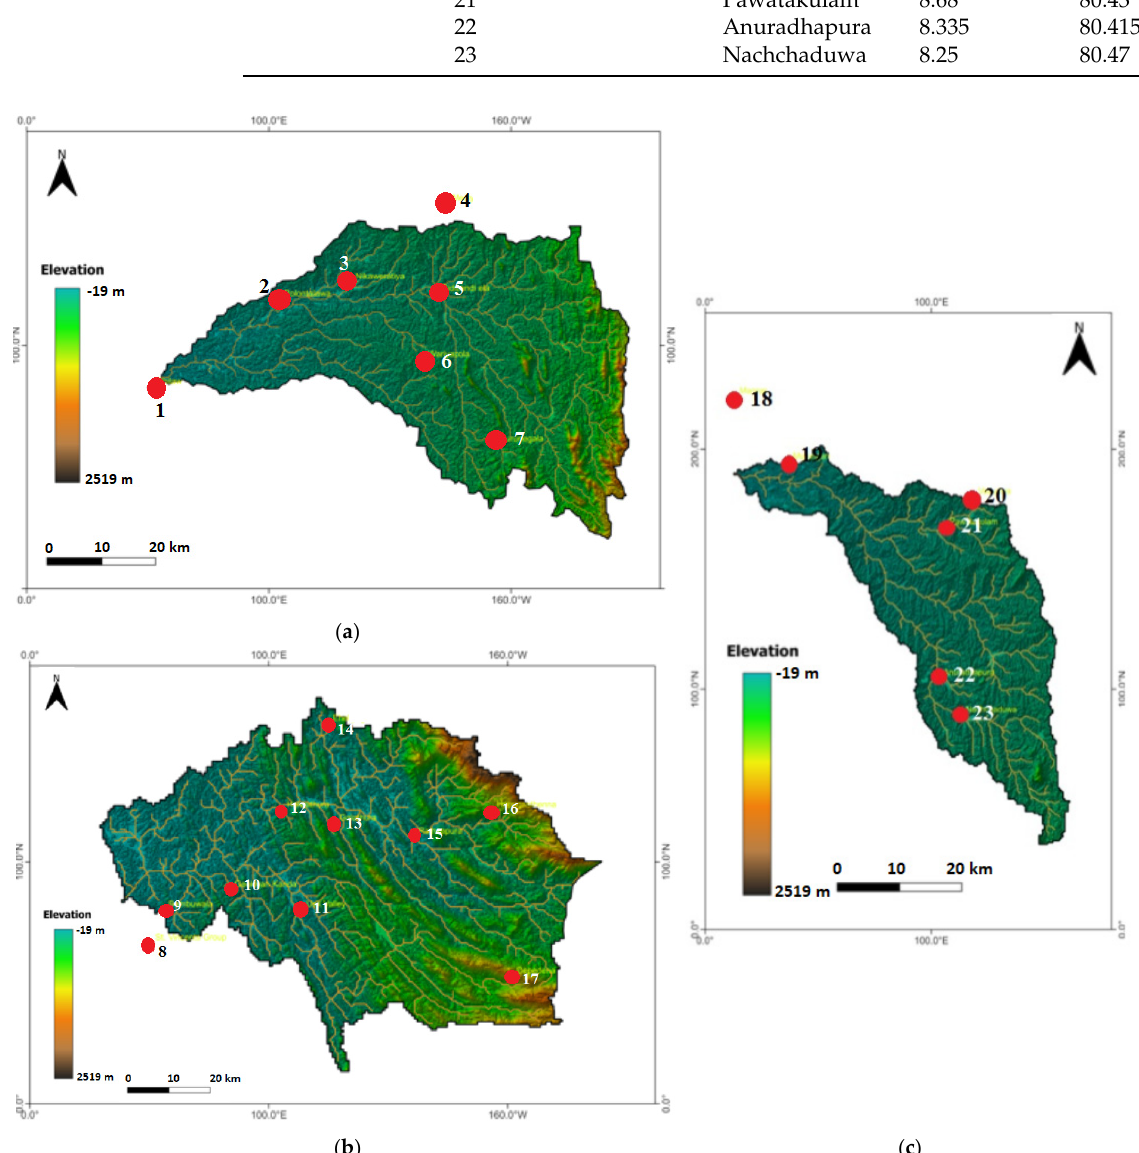
Figure 3. Elevation maps with rain gauges: ( a ) Deduru; ( b ) Kalu; ( c ) Malwathu. Malwathu River basin has a rain gauge density of 1.8 gauges per 1000 km 2, whereas the Deduru River basin has a rain gauge density of 2.7 gauges per 1000 km 2 . However, the Kalu River basin is denser in rain gauges and has a density of 3.6 gauges per 1000 km 2 which is higher than the rain gauge density for most of the research studies that incorpo- rate evaluating SRPs for different areas of interest [16,22–24]. However, these densities clearly showcased their non-homogeneous spatial distribution in a particular river basin. Missing data for each basin were less than 10%, and the missing data were filled either by using rainfall data from nearby stations or by obtaining APHRODITE data which contain rainfall data for the whole of Asia [25]. 2.3. Satellite Rainfall Products To evaluate the effectiveness of SRPs with respect to rain gauge data, six SRPs were considered, namely, PERSIANN, Precipitation Estimation from Remotely Sensed